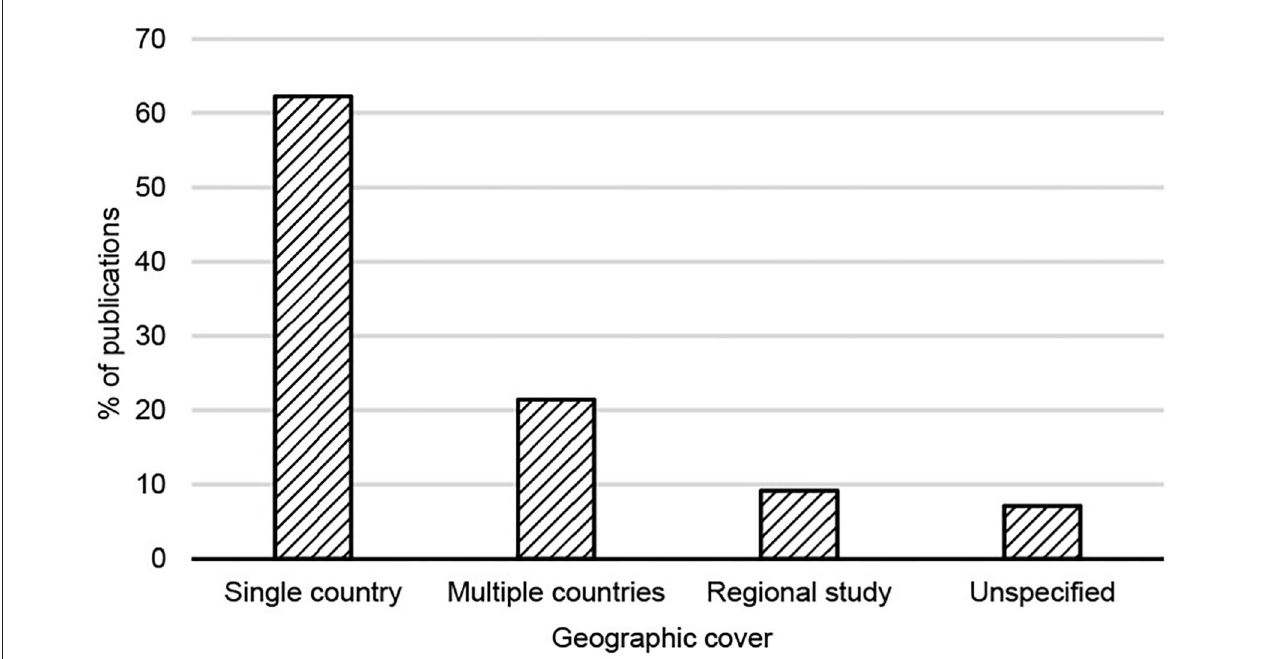
FIGURE 3 | SES studies per geographic context. The figure shows the percentage of studies on coastal or marine SESs that took place in a single country (single), in more than one country (multiple countries), in a broader geographic area regardless of the country (regional), and in unspecified locations (unspecified).